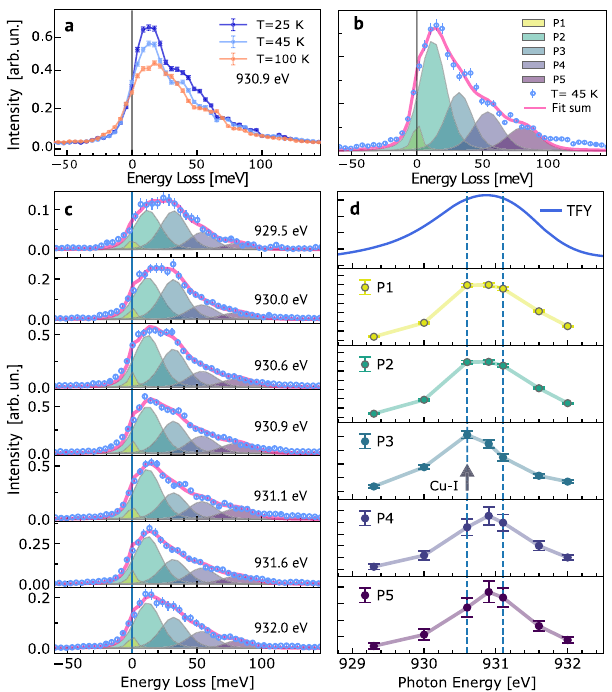
Fig. 4 Magnetic excitations in Cu 2 OSeO 3 . a High-resolution resonant inelastic X-ray scattering (RIXS) spectra measured at an incident energy of 930.9 eV, q = [1.3,0,0] r.l.u. for T = 27, 45, and 100 K, with π polarized light. The zero-energy was determined with reference to a carbon tape placed on the sample. b Fitting analysis of the 45 K RIXS spectrum, using fi ve Gaussian peaks with a fi xed width, fi xed center position (allowing ±5% variation w.r.t. the values presented in the main text), and free amplitude. Raw data were displayed as open dots. The fi tting sum is the solid line. The error bars are de fi ned assuming a Poisson distribution of the single-photon counted events. c Repeating the fi tting analysis for all RIXS spectra measured across the Cu L 3 resonance. d Summary of the integrated intensity for each fi tting component, as a function of the incident photon energy (dot symbols). The error bars are extracted from the fi tting, through the error propagation method. The smoothed lines underneath are a guide for the eyes. The Cu L 3 absorption spectrum is reproduced on top to ease the